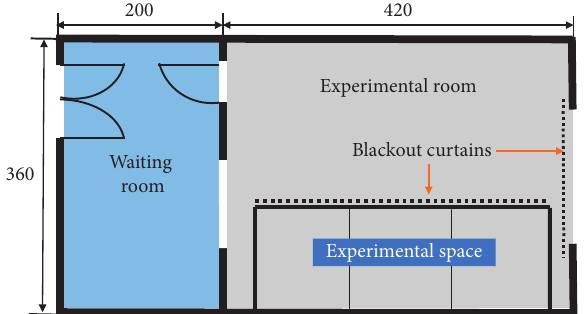
Figure 3: Interior structure of experimental laboratory.